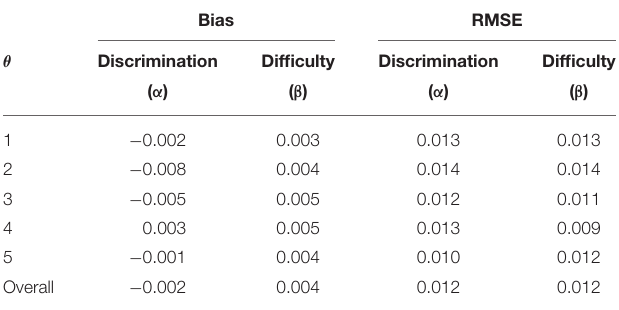
TABLE 4 | Bias and RMSE of the discrimination and difficulty parameter estimates of the 150 items. Bias RMSE θ Discrimination Difficulty Discrimination Difficulty